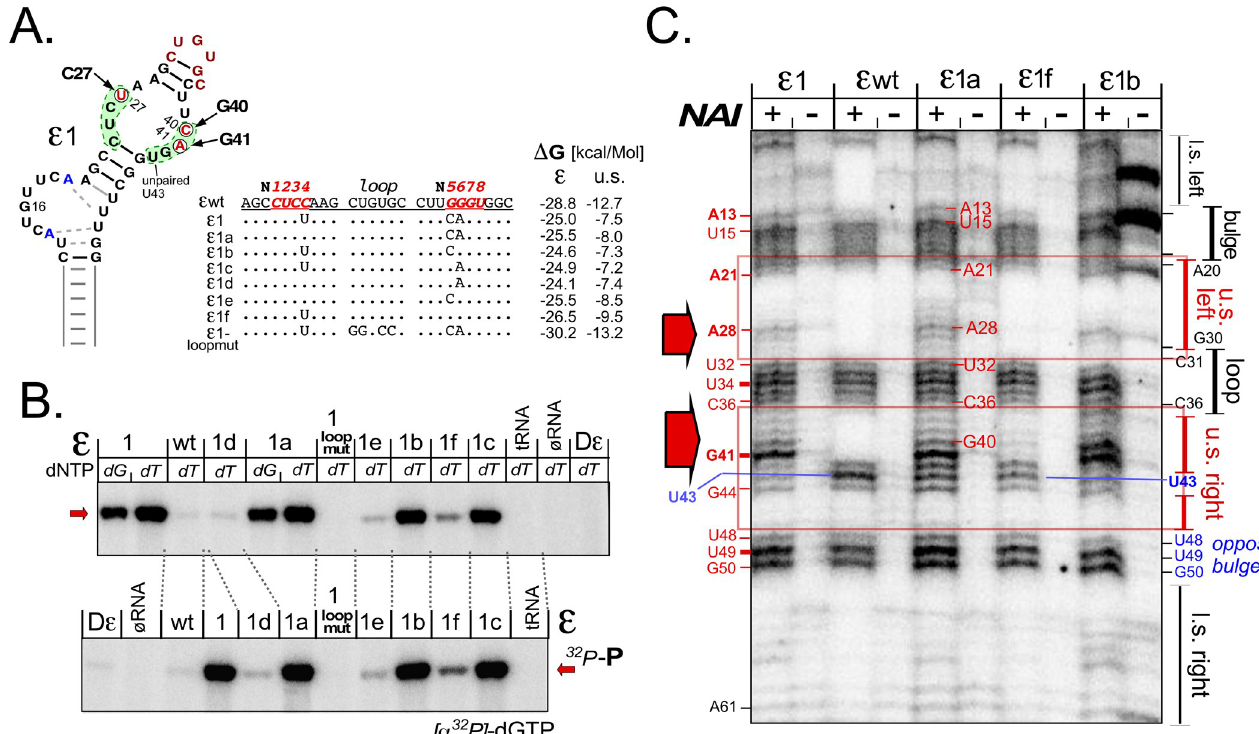
Fig 5. Two upper stem mutations are necessary and sufficient for robust in vitro priming with renatured HBV miniP. (A) Scheme of secondary mutations introduced into variant ε 1. To further approximate ε 1 to wt ε its three mutations were individually and in combination reverted, yielding variants maintaining two ( ε 1a,b,c) or only one mutation ( ε 1d,e,f); in addition, four loop mutations preventing pgRNA packaging in cells were introduced into ε 1 context ( ε 1- loopmut ). Δ G values were derived as in Fig 2. (B) In vitro priming activities with renatured HBV miniP. Assays with the indicated RNAs were performed as in Fig 4B, using α 32 P-dTTP ( top ; except in lanes labeled dG) and α 32 P-dGTP (bottom ). The double mutants performed similarly well with either dNTP while signals from the single-site mutants were much weaker and the loop mutant gave no signal at all. (C) Robust priming activity correlates with a loosened upper stem. The indicated RNAs were analyzed by SHAPE at 37˚C as in Fig 3. Highly priming active variants ε 1, ε 1a and ε 1b showed extra signals around A28 and between C36 and G41 ( red arrows ), with the G41 signal exceeding that from U43, indicative of an ε 1-like open upper stem structure. The band pattern of the poorly priming variant ε 1f essentially conformed to that from wt ε